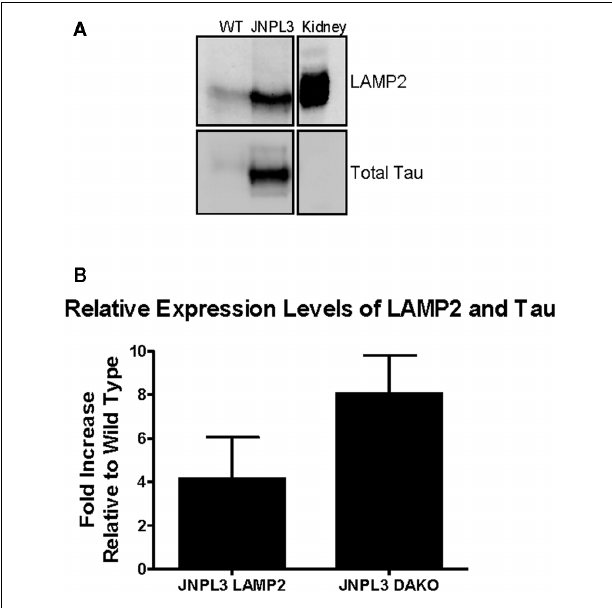
FIGURE 4 | Non-immunized JNPL3 mice have more lysosomes than WT mice and these contain tau. Brain slices (400 μ m) were processed to obtain an enriched lysosome fraction. (A) Representative immunoblot showing the presence of lysosomes (LAMP2) and tau (DAKO A0024) was confirmed in fractions from bothWT and JNPL3 mice. Mouse kidney lysate was used as a positive control. (B) Quantification of immunoblots indicated that non-immunized JNPL3 mice had fourfold more lysosomes thanWT mice, with corresponding eightfold higher amounts of tau ( n = 3 separate